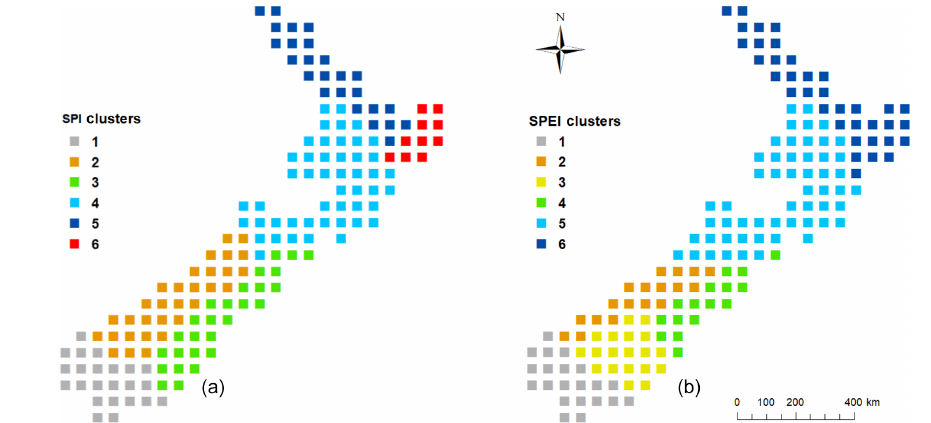
Figure 4. Spatial expression of clusters for the SPI (a) and SPEI (b)